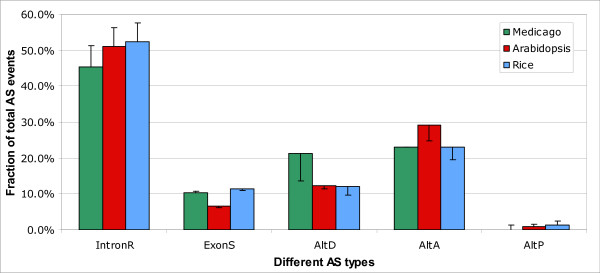
Ratio of different AS types in a reliable subset of AS events. The reliable data set consisted of AS events with multiple supporting ESTs for each isoform. IntronR is still the most abundant AS type in the subset. The error bar represents the ratio for each AS type in full data set described in Table 2.